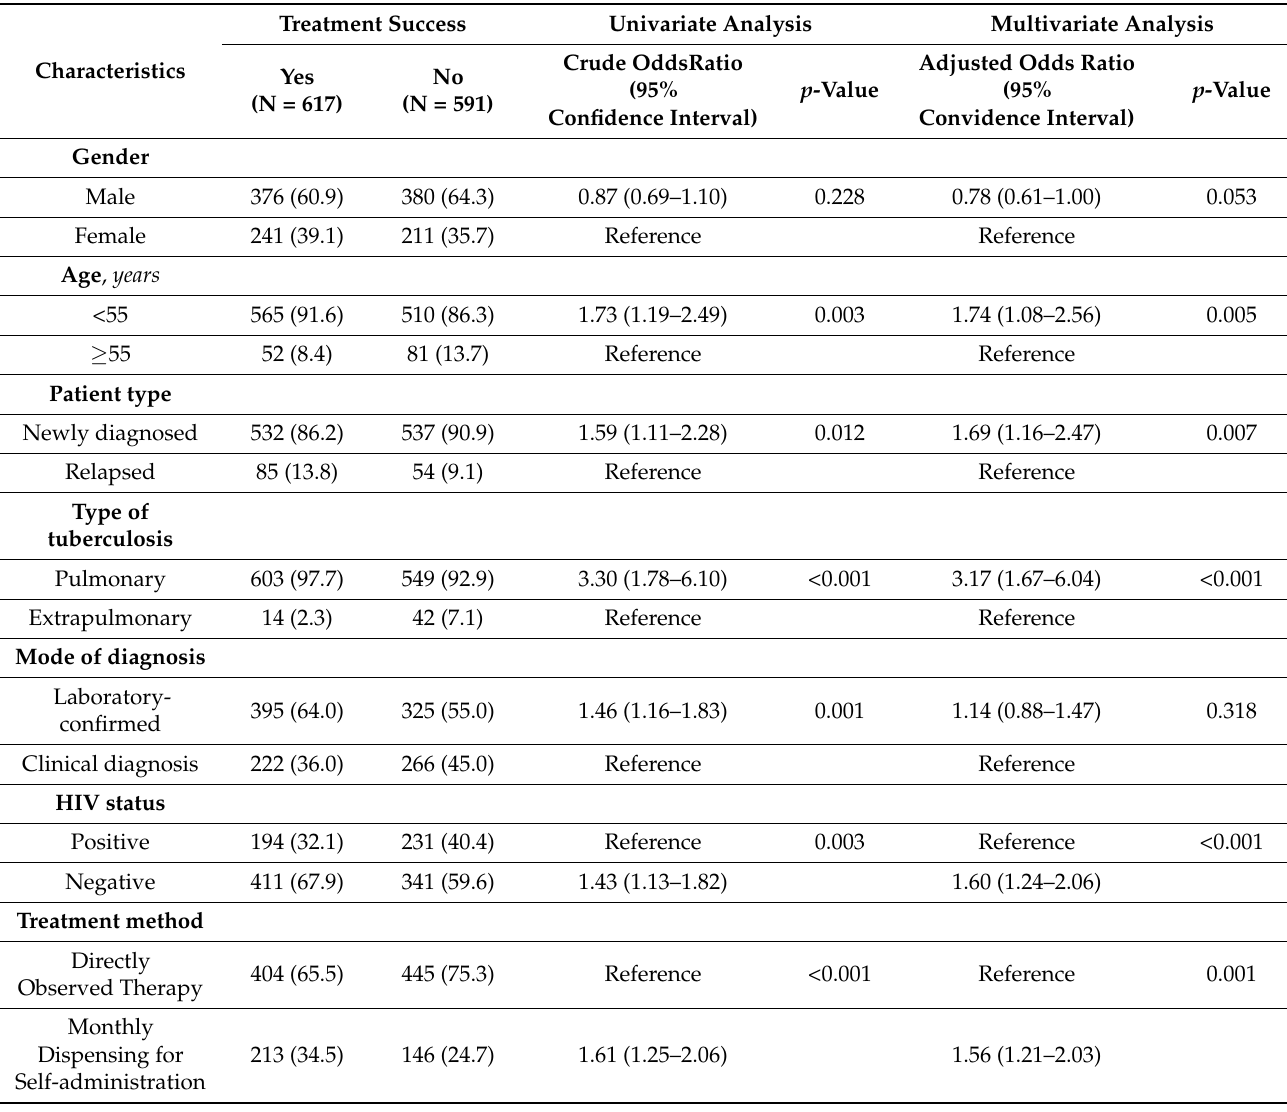
Table 3. Predictors of TB treatment success during the pre- and intra-COVID-19